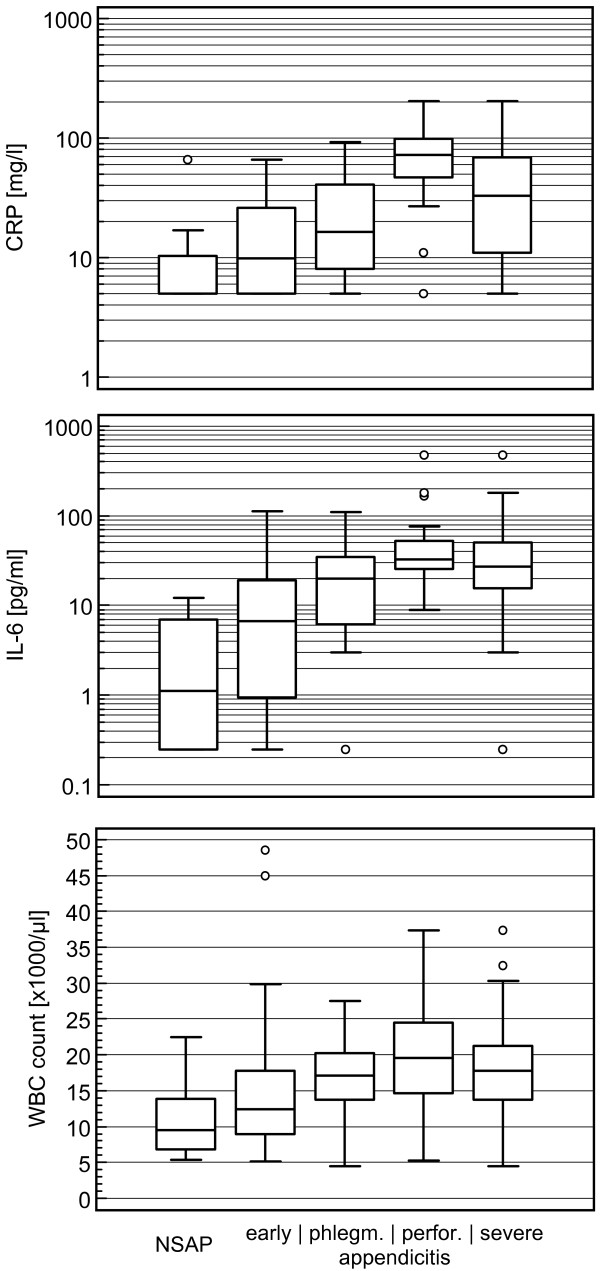
CRP, WBC count, and IL-6 show a strong correlation to the grade of local inflammation (p < 0.0001).